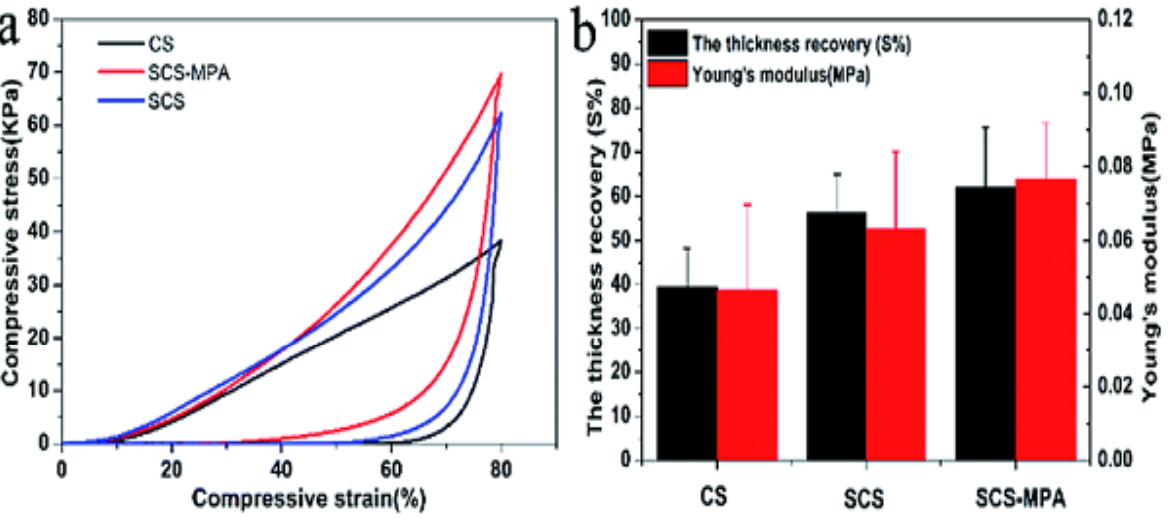
Figure 4. ( a ) Compressive stress – strain curves of unmodified ( b ) thickness recovery and Young’s modulus of unmodified silylated cellulose (CS), silylated cellulose sponge (SCS), and silylated cel- lulose sponge Young’s modulus (SCS-MPA). (Copyright and permission, RSC-2022). With n-dodecyl mercaptan (NDM), 2-aminoethanethiol hydrochloride (AET), and monothioglycerol (MG), amphiphilic cellulose (MCC-C16) improves the antifouling capa- bilities of the poly(acrylonitrile-co-methyl acrylate) ultrafiltration membrane. The reaction of MCC with 1-bromohexadecane in the mentioned aqueous solution (6 wt% NaOH/4 wt%) yielded MCC-C16. A solution of 7 wt% NaOH/12 wt% urea was used as a